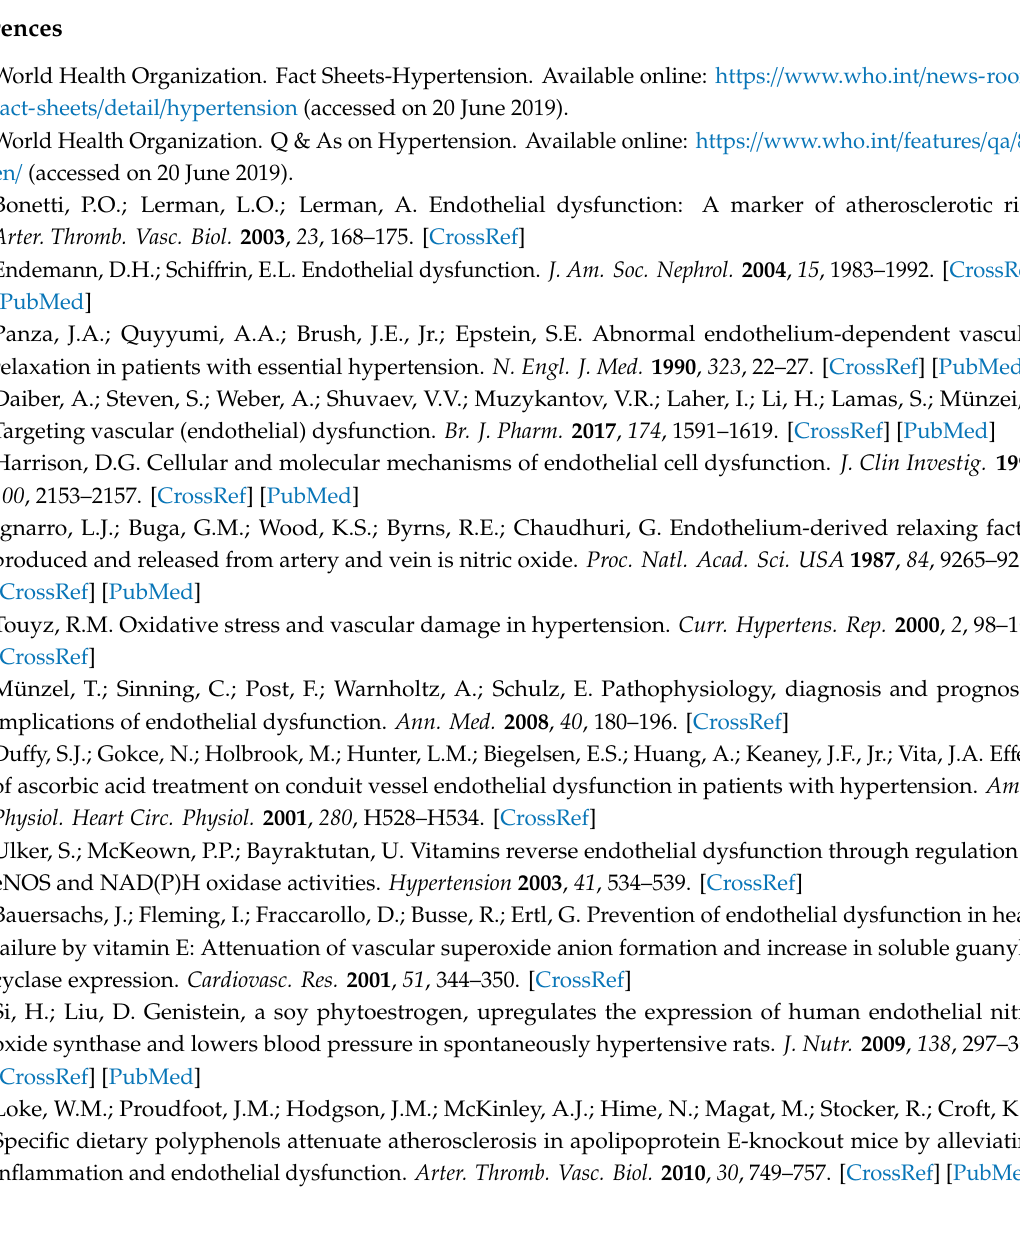
Table S1: Parameters before and after the intervention in each